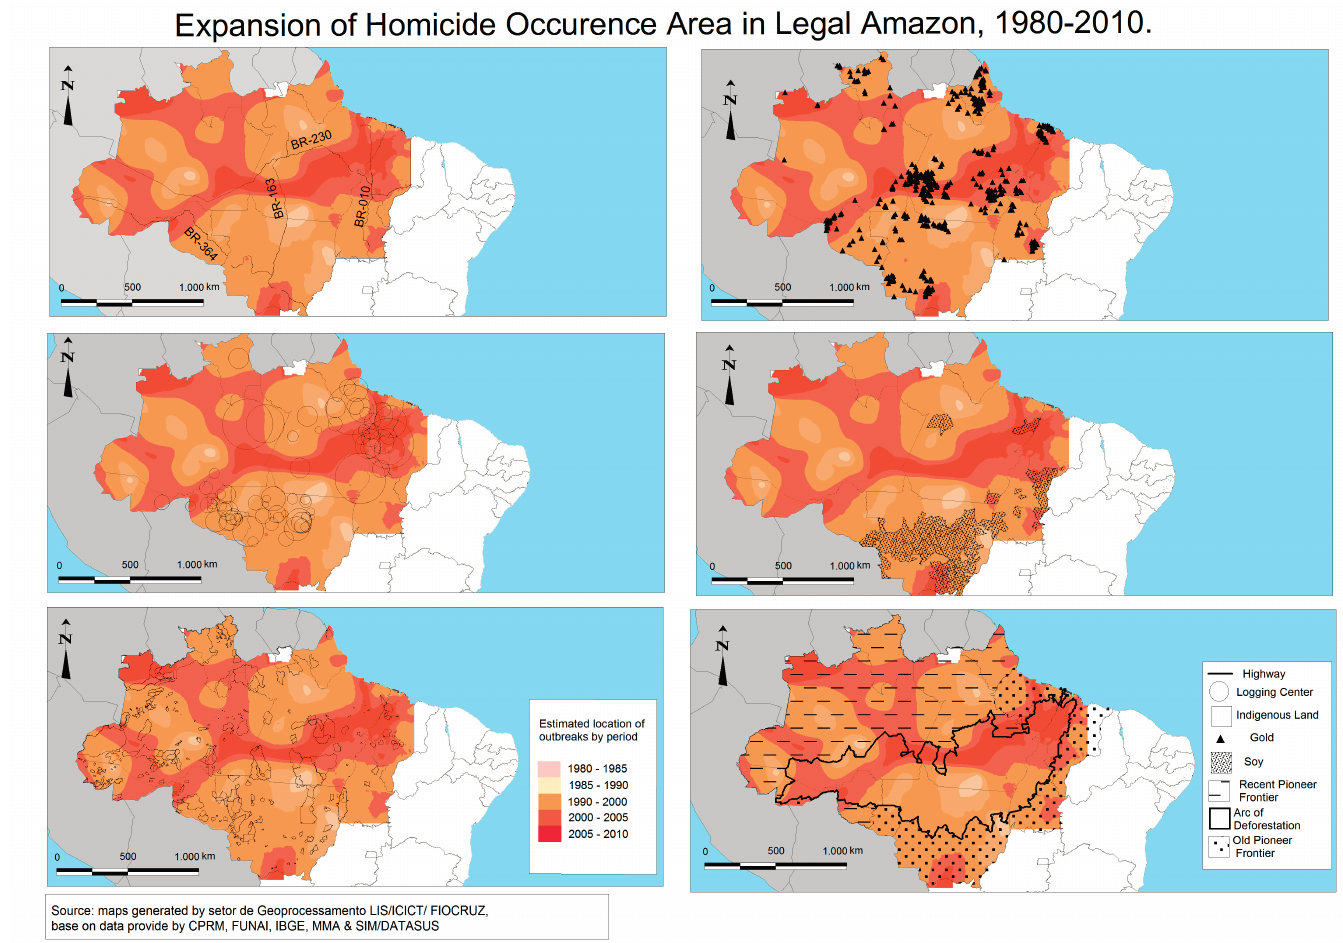
Figure 3. Hotspot maps of homicide and socio-environmental determinants in the Legal Amazon, 1980–2010. Source: SIM/DATASUS